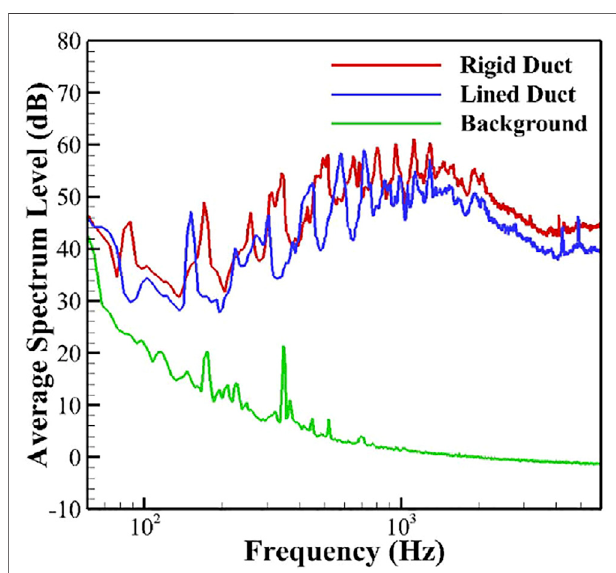
FIGURE8| Averaged spectrum levels overthemicrophonesinthearray for the propeller with a rigid duct, a lined duct, and the